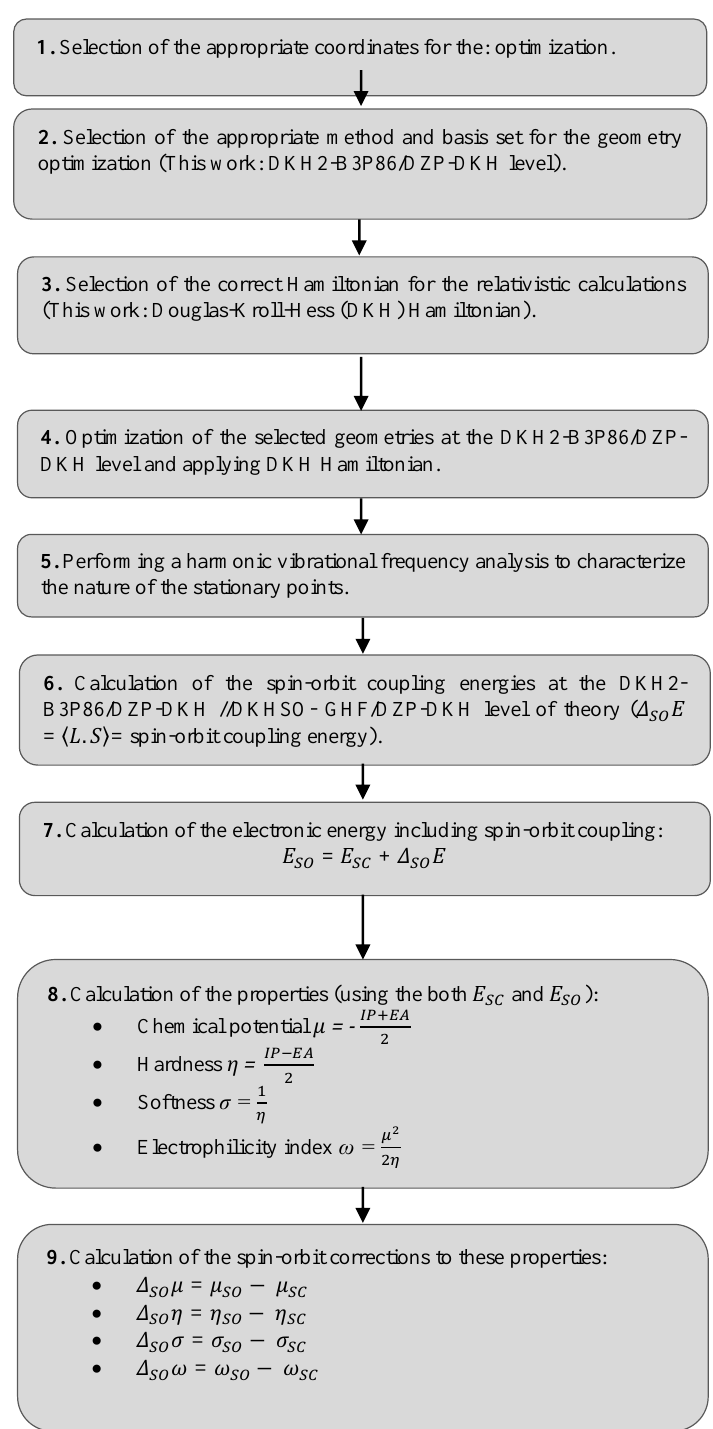
Figure 1. Flow diagram showing the computational